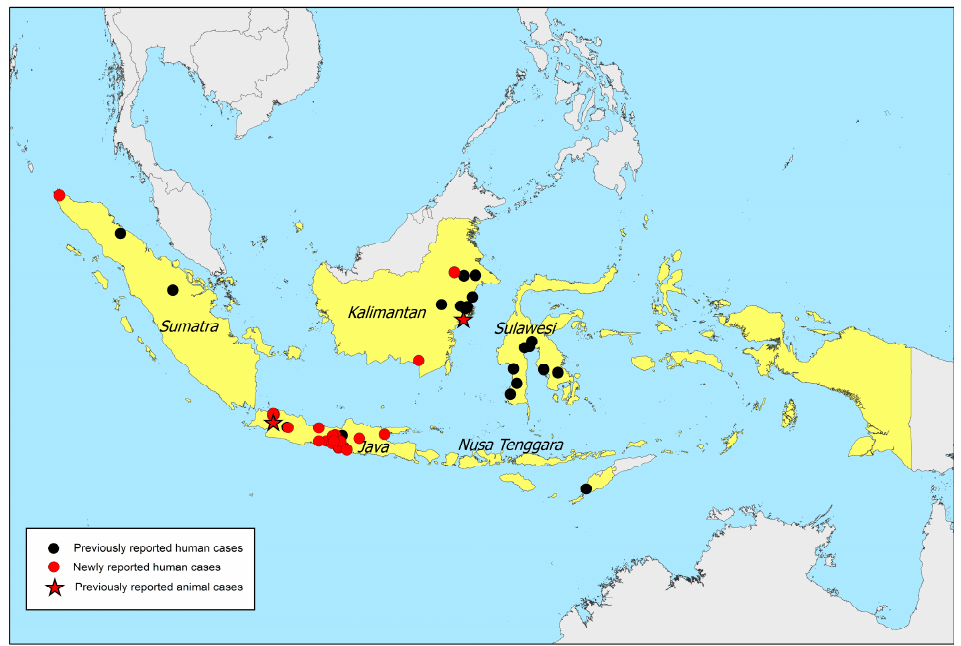
Figure 1 . Location of 146 melioidosis cases. Black dots represent locations of 99 previously-reported human cases, red stars represent locations of two previously-reported animal cases and red dots represent locations of 45 newly-reported human cases. An interactive map is available at melioidosis.info website [25].